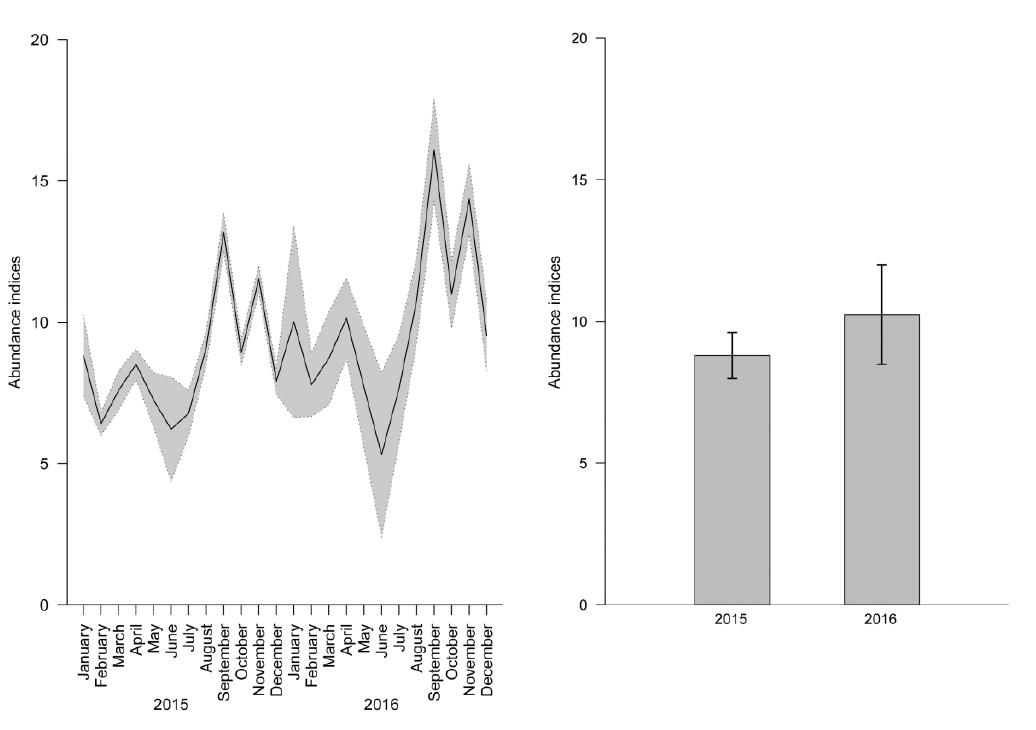
Figure 5. Abundance indices of the silky shark in the Indonesian Fisheries Management Area 573 by month ( left ) and year ( right ). Both figures showed mean value and the respective 95% confidence interval.